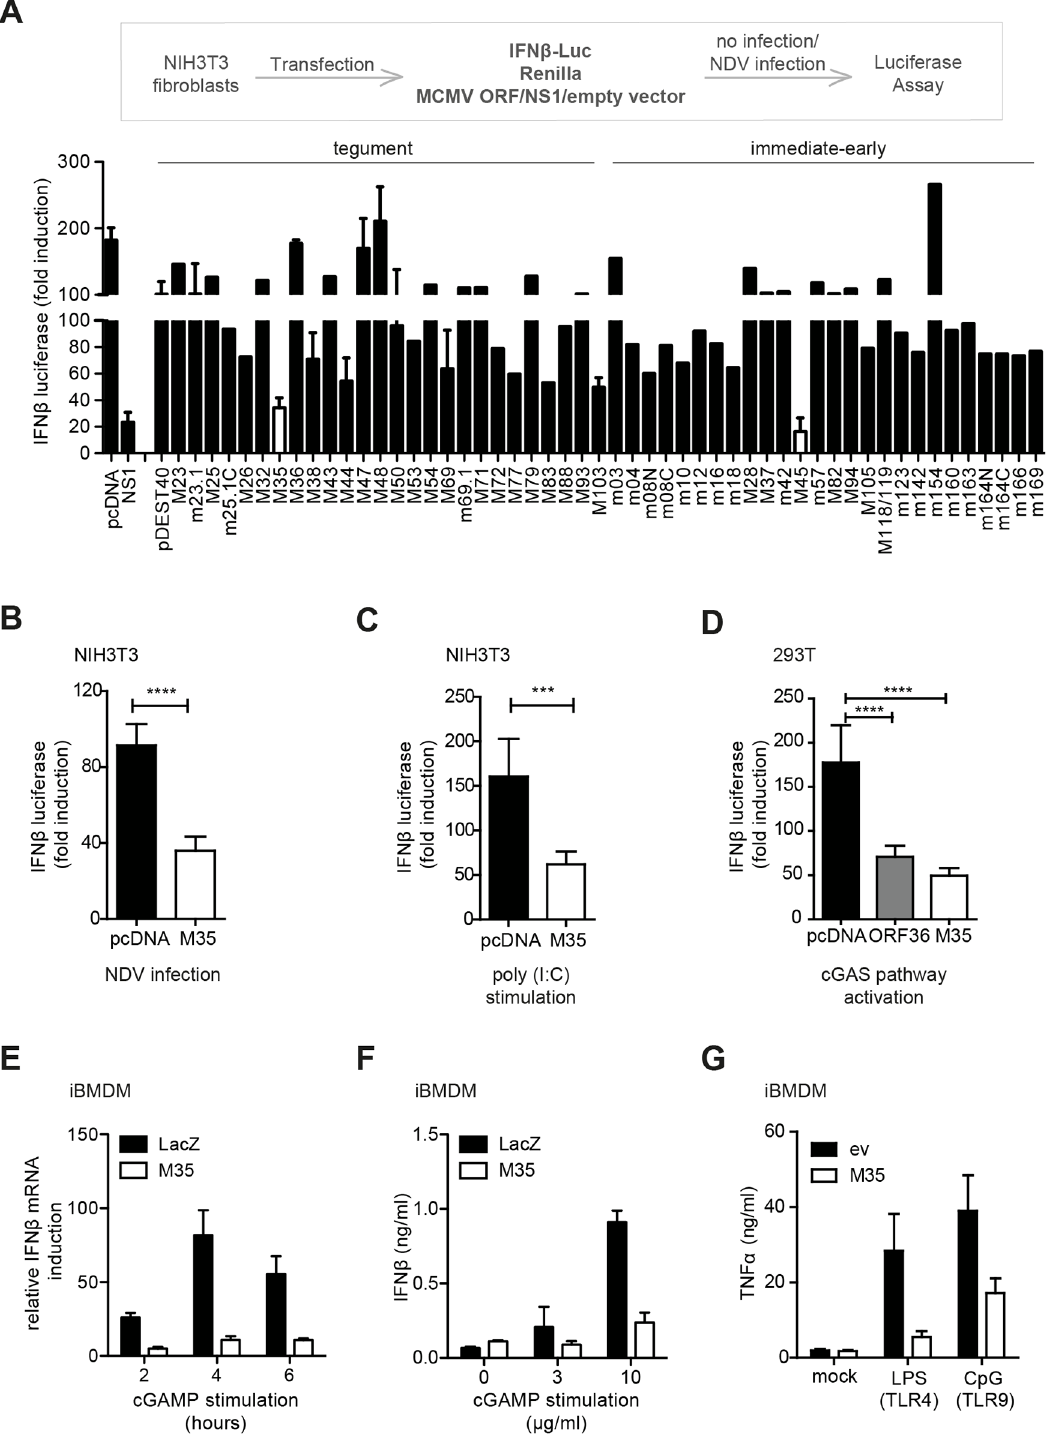
Fig 1. The MCMV M35 protein inhibits signaling of multiple pattern recognition receptors. (A) NIH3T3 fibroblasts were co-transfected with a reporter plasmidcontaining firefly luciferaseunder the control of the murineIFN β promoter (IFN β -Luc)together with a Renillaluciferase normalization control (pRL-TK) and influenzaNS1 or MCMV ORFs known or predictedto code for tegument or immediate-early proteins or their corresponding empty vector (pcDNA and pDEST40, respectively). At 24 hours post transfection, cells were treated with medium or stimulatedby infection with Newcastle